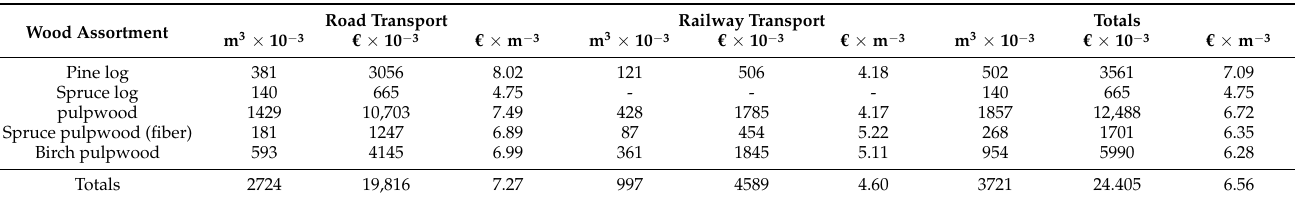
Table 3. Wood procurement area’s optimum transport amounts per wood assortment in thousands of cubic meters in the baseline scenario. Transport costs are in thousands of euros and volume-weighted